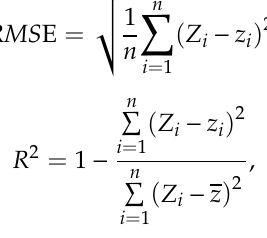
Figure 4. Spatially discounted reconstruction loss.